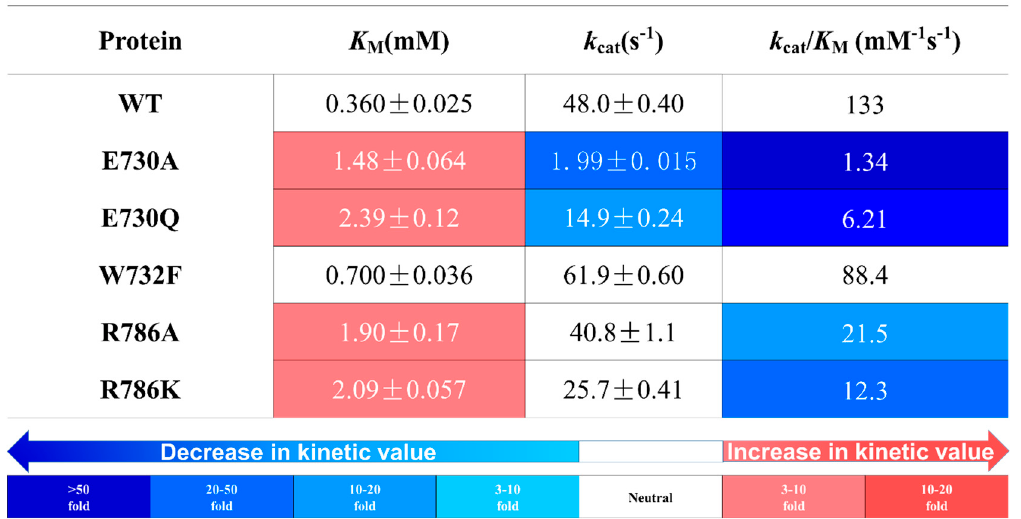
Figure 4. Kinetic constants of the Tx GH116 wild type (WT) enzyme and mutants with cellobiose substrate. The heat map represents the fold changes in each k cat , K M , and k cat / K M mutant relative to the WT enzyme. Red represents different fold increases, and blue represents different fold decreases (from light to dark with increasing fold change).